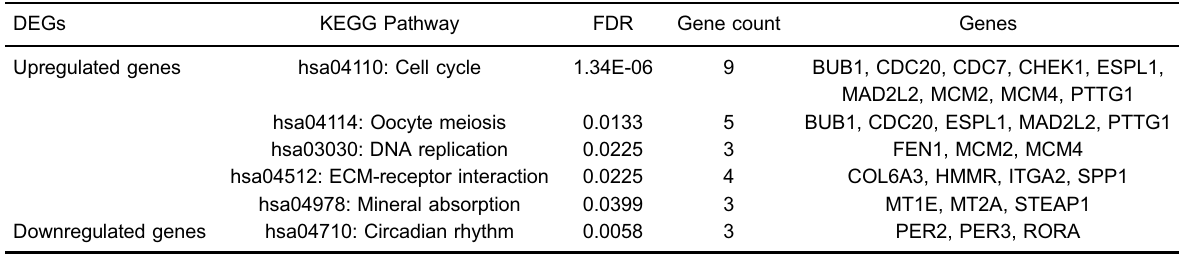
Downregulated genes FDR: false discovery